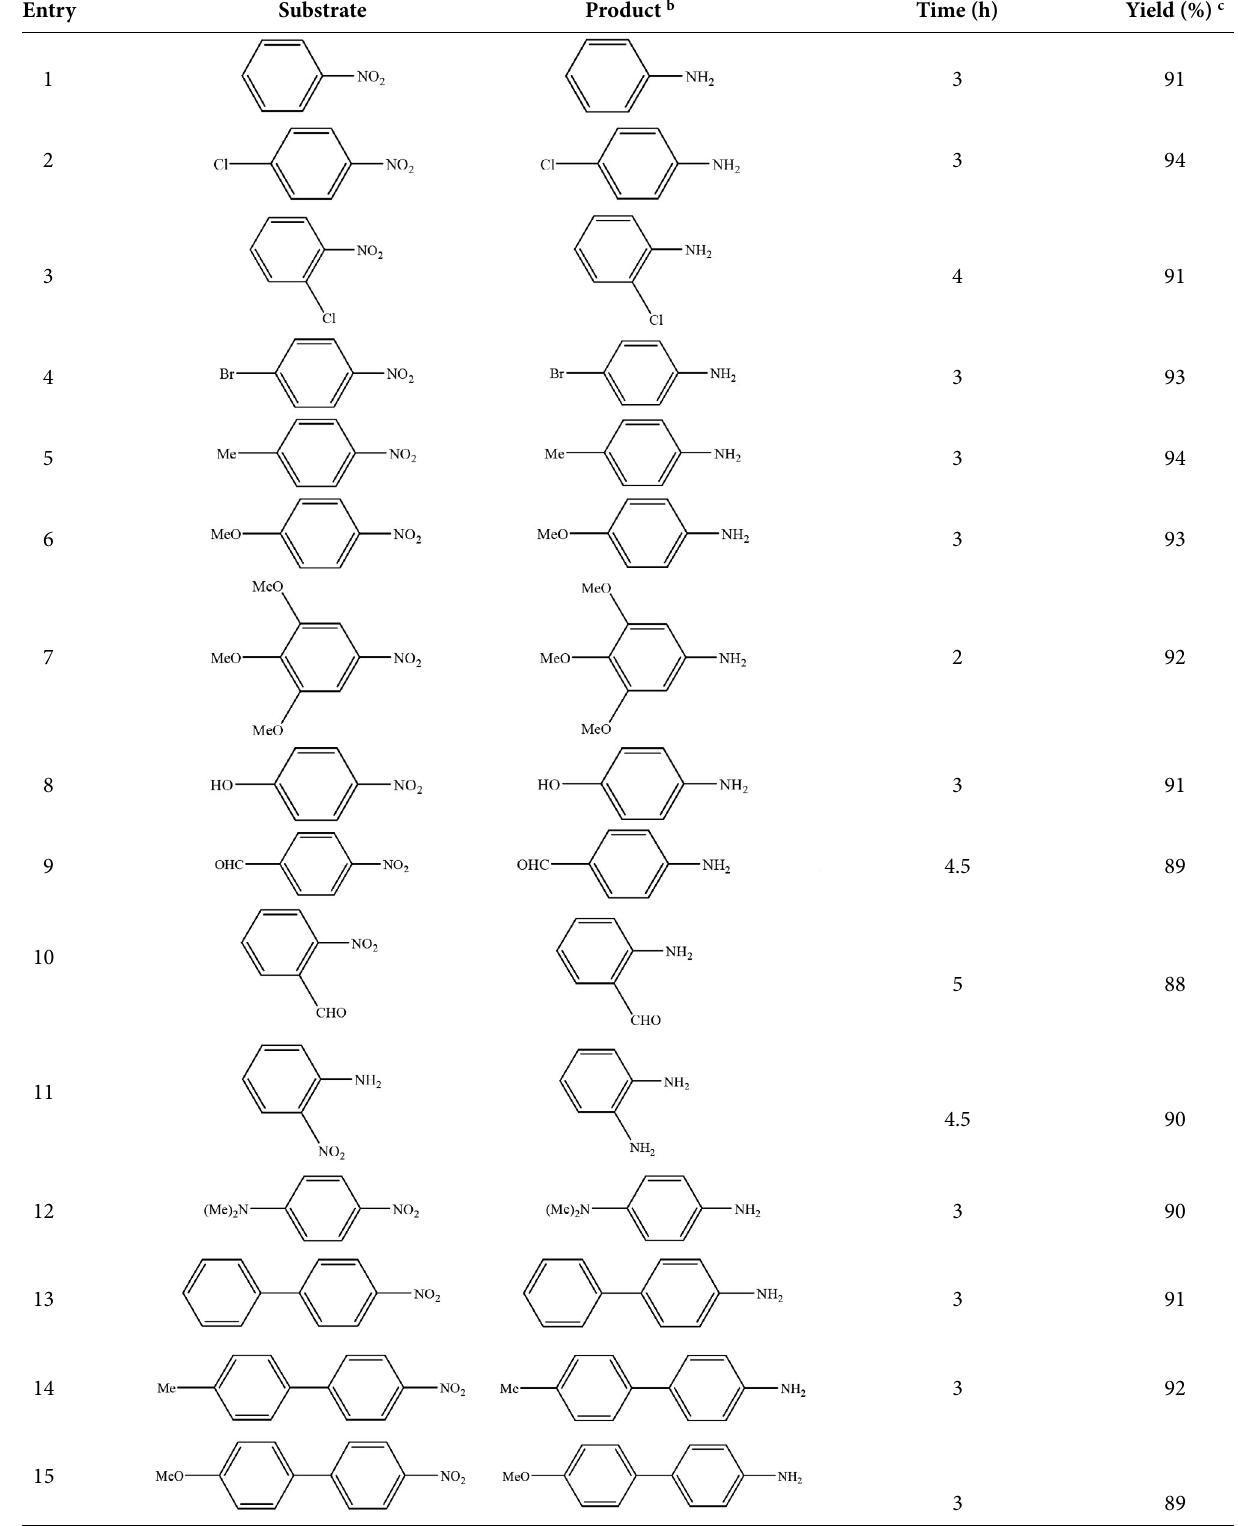
Entry Substrate Product